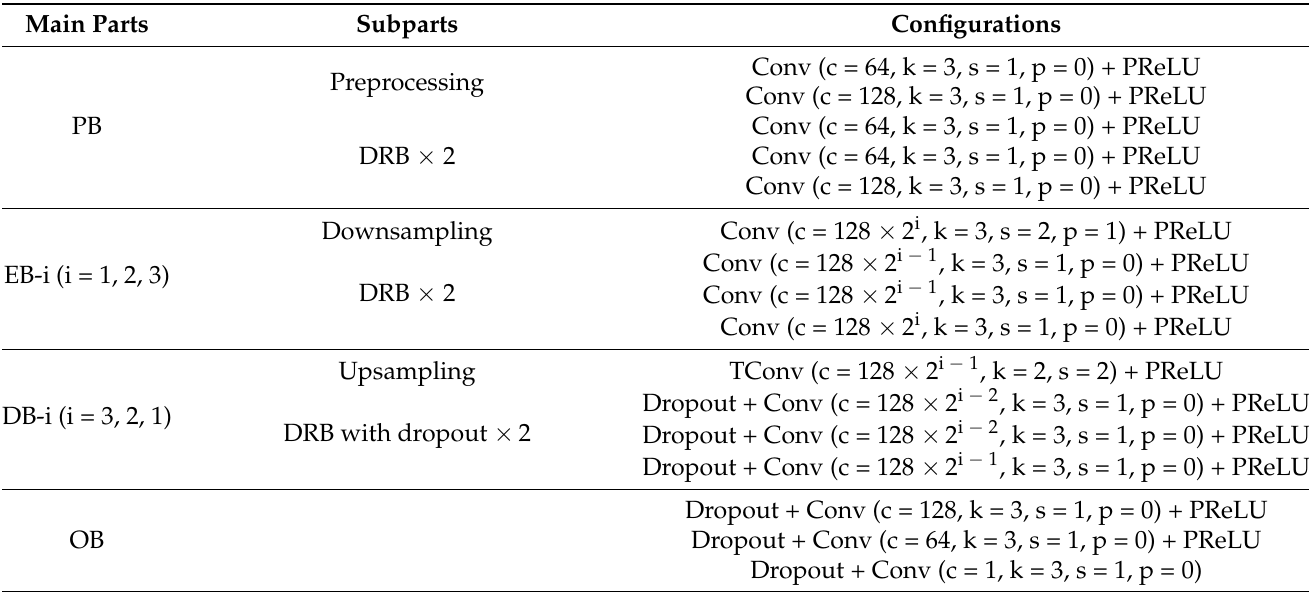
Figure 4. Architecture of our proposed MSDNet. Table 1. Detailed configuration of our proposed